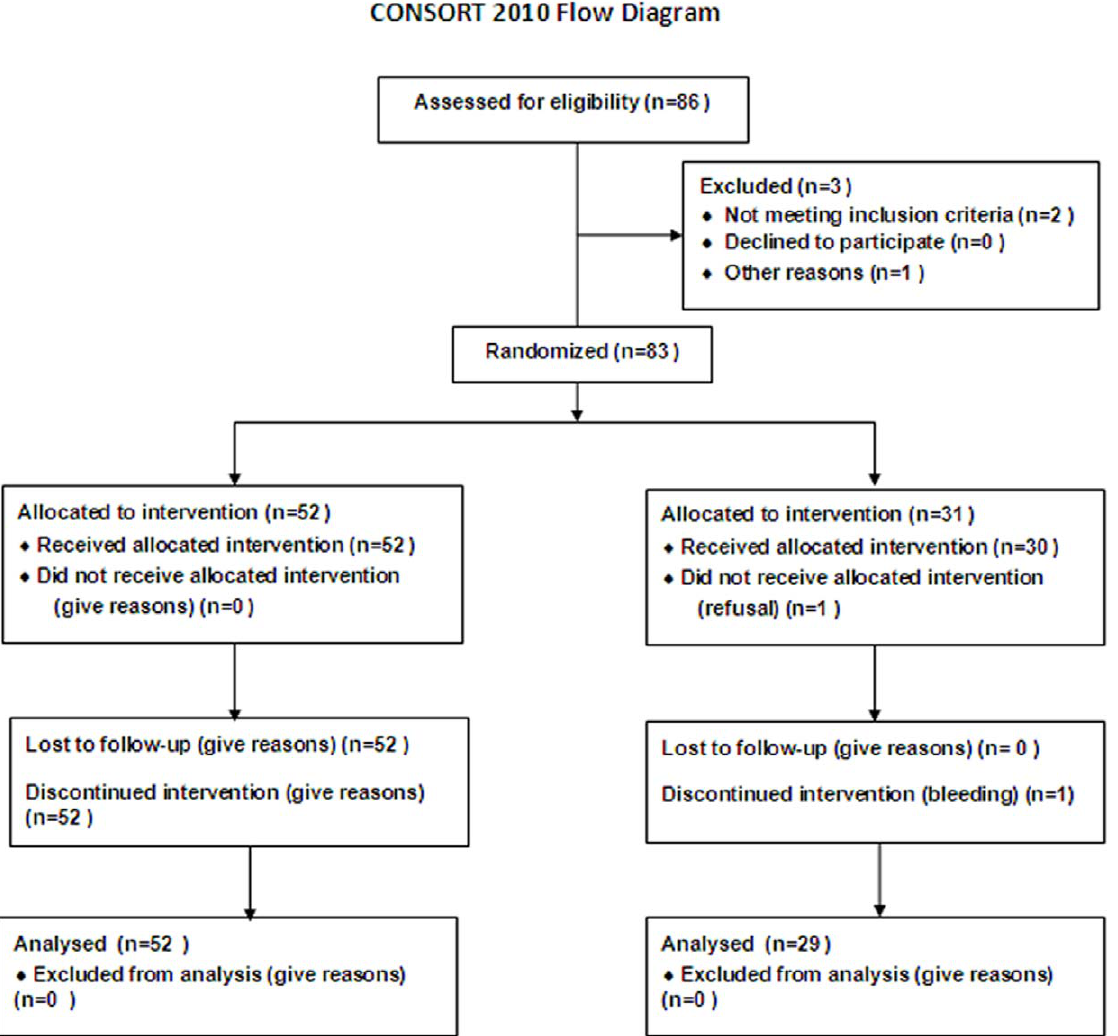
Figure 1. Enrollment of patients with cirrhosis and portal hypertension.